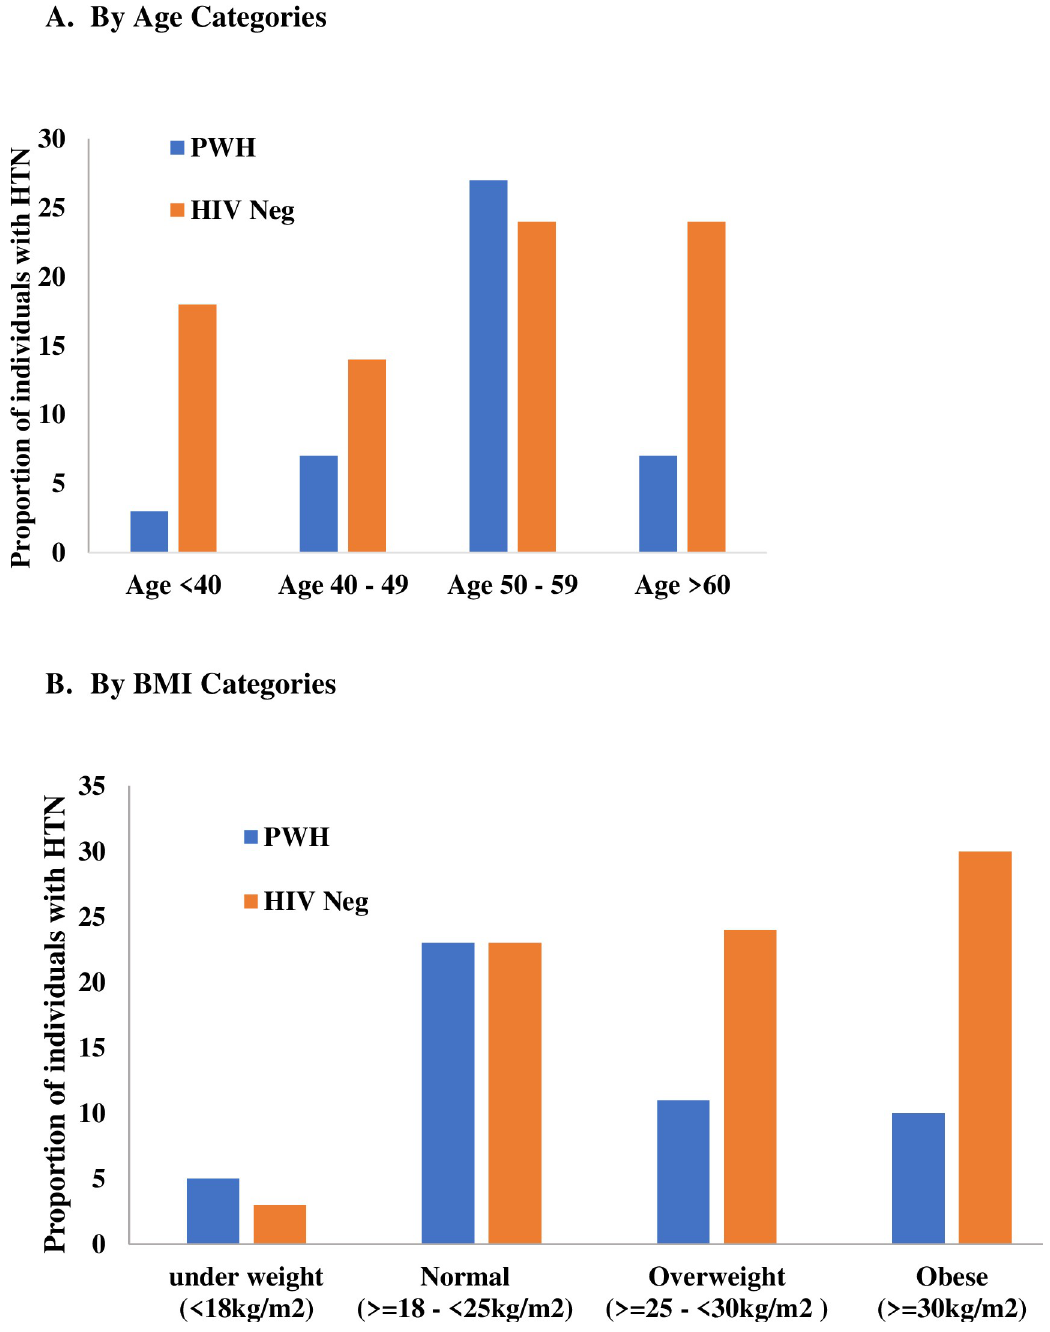
Fig 1. Prevalence of hypertension among PWH and HIV negative